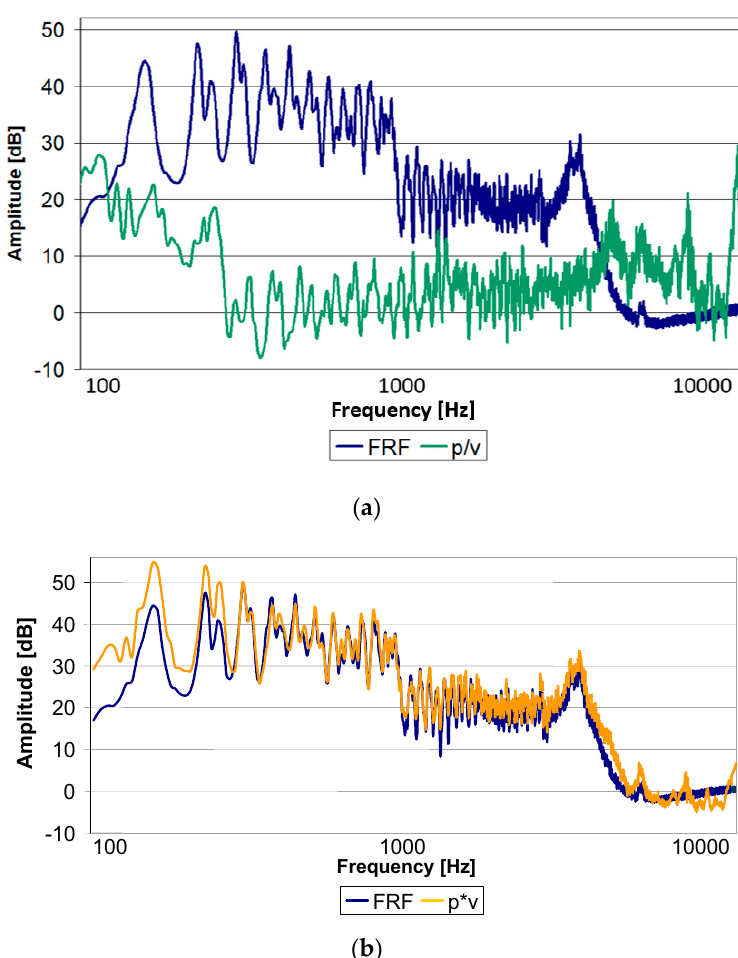
Figure 2. Tympani: ( a ) FRF compared with p / v ; ( b ) FRF compared with IAR.